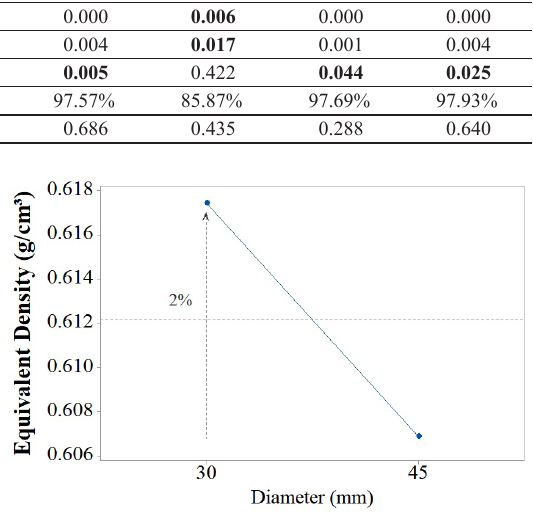
Figure 5. Main effect plot for the mean equivalent density.